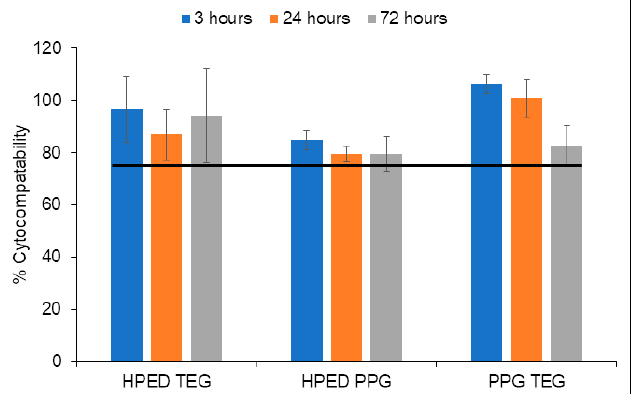
Figure 4. Cytocompatibility of 3T3 mouse fibroblasts over 72 h in the presence of HPED TEG, HPED PPG, and PPG TEG loaded with 100 mg of mnp/8 g of polymer. Mean ± standard deviation displayed. n = 3. The horizontal line denotes ISO 10993-5 standard (75% cytocompatibility).